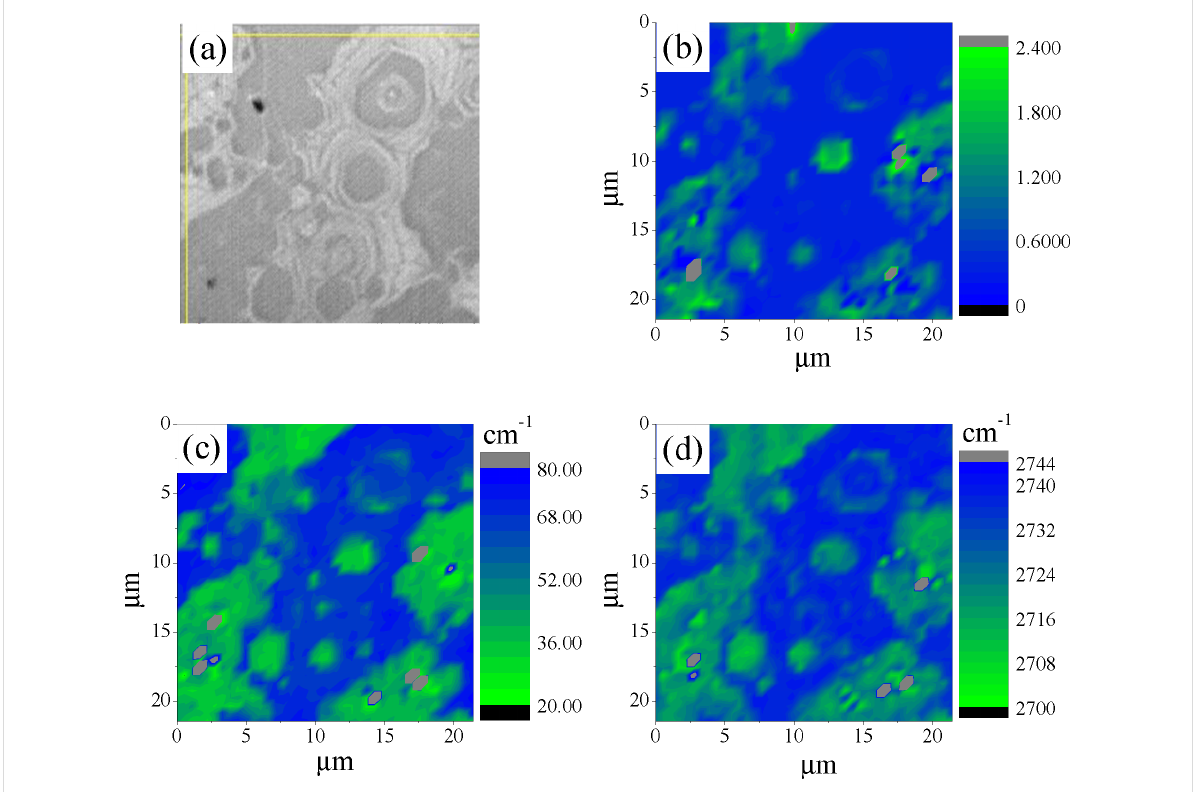
Figure 3: (a) The Rayleigh image. (b) I 2D / I G ratio map. (c) FWHM map of the 2D band. (d) 2D band position map. All data are for sample A on SiO 2 /Si substrate acquired with a laser excitation wavelength of 473 nm. Color coding represents the amplitude of measured values.